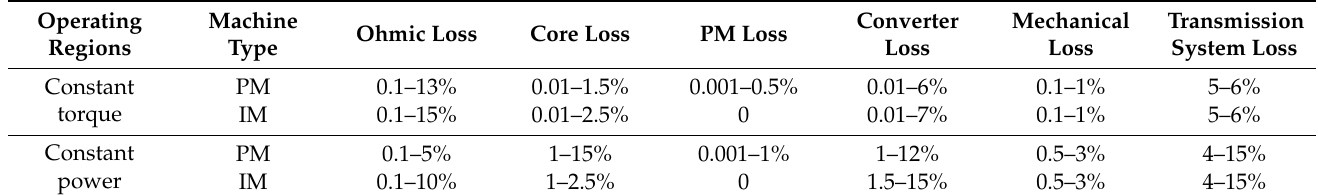
Table 4. Range of the variation each type of loss as a percentage of the maximum power of the machine in the constant torque and constant power regions for IMs and IPMSMs